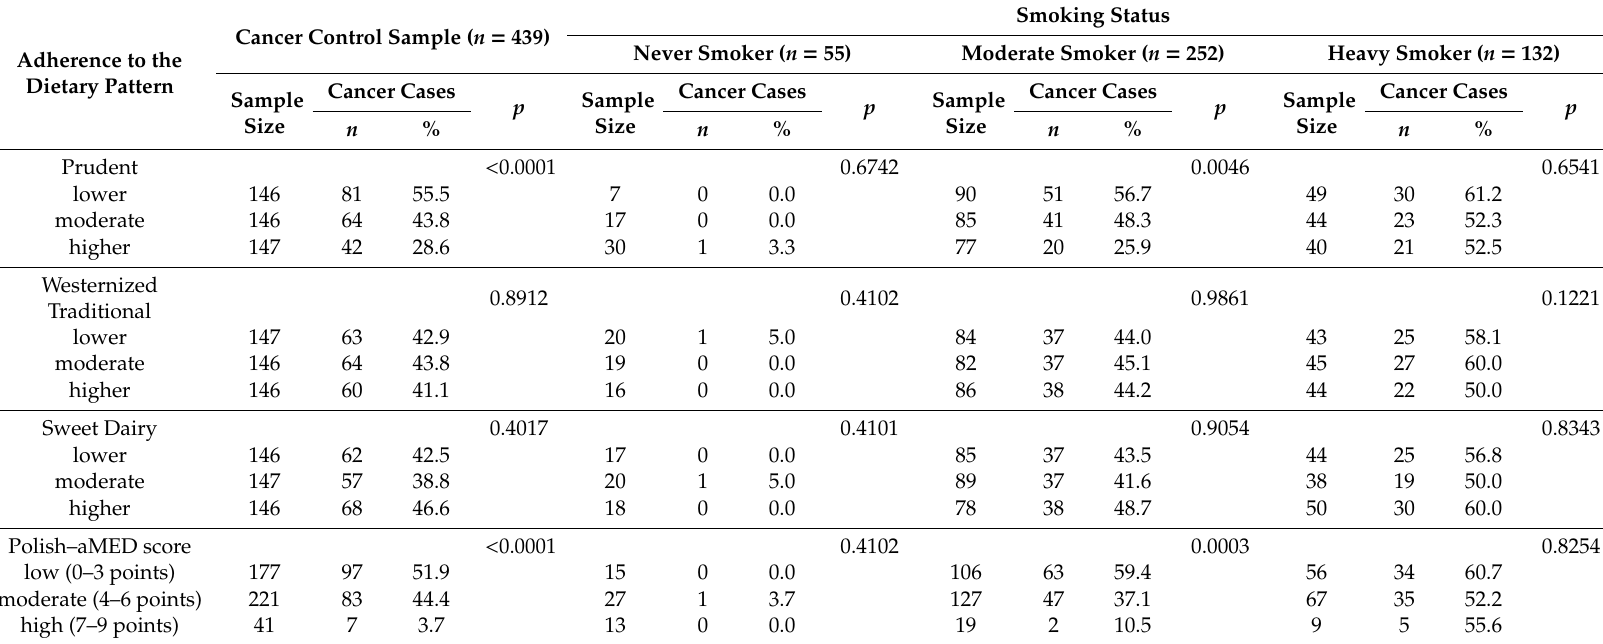
Table 3. Distribution of lung cancer cases by adherence to the dietary patterns and smoking